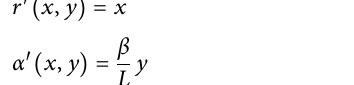
parameters of these four homogeneous materials can be = 1,250 kg/m 3 , K A = 2.25 GPa, ρ obtained as: ρ A